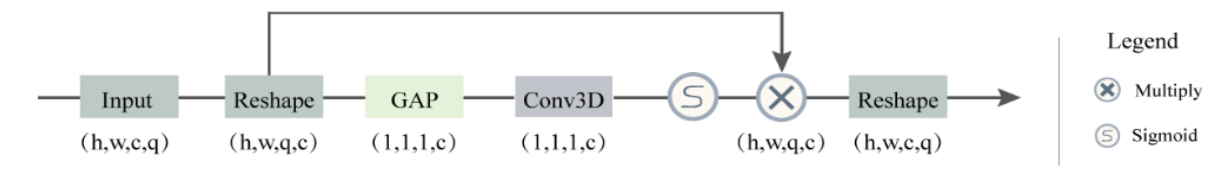
Figure 2. The architecture of the channel attention module.